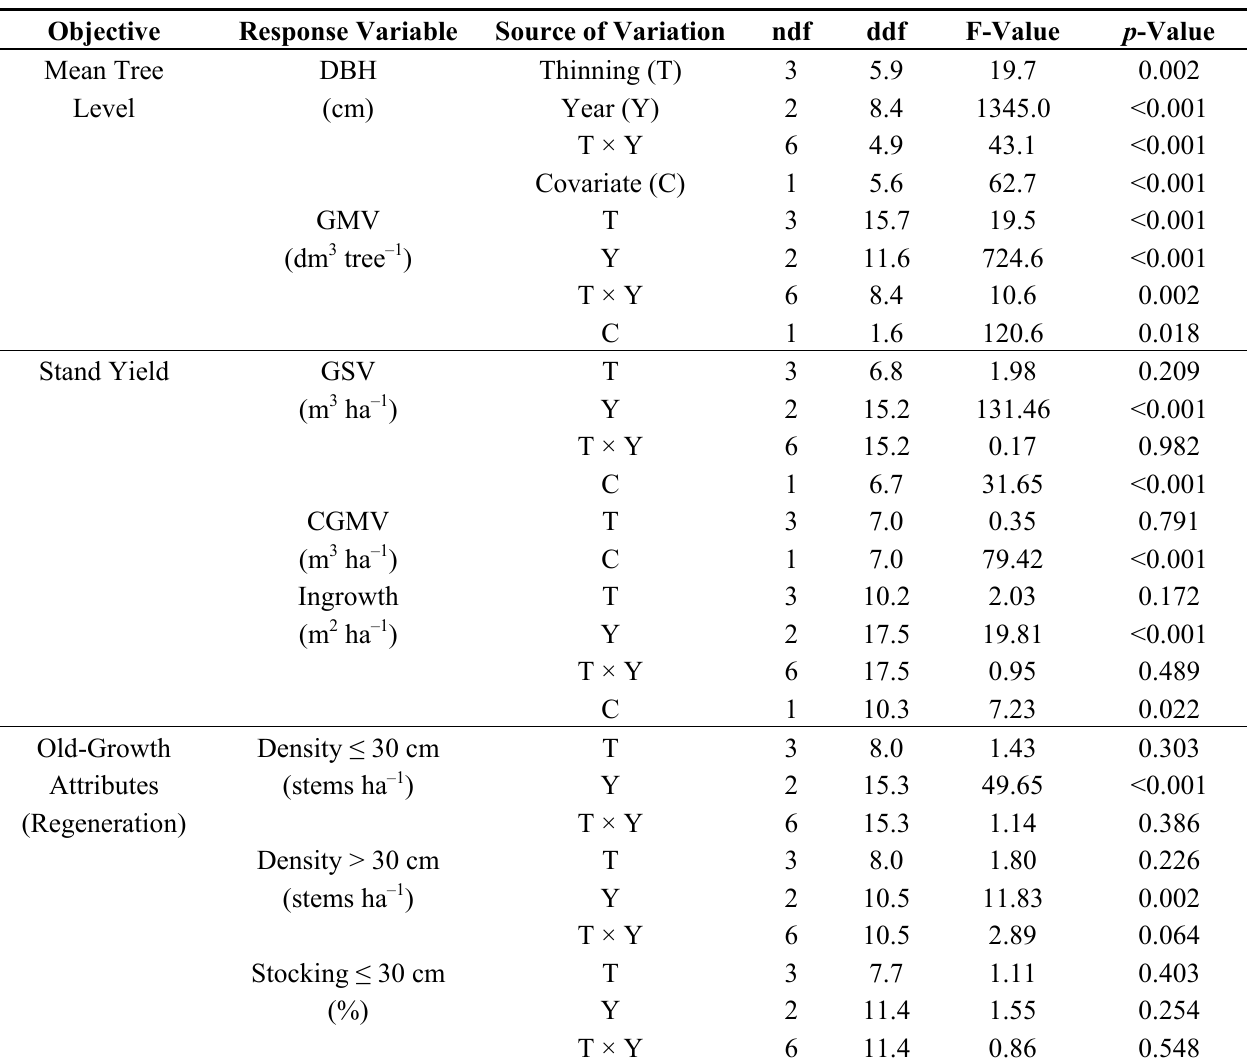
Table 2. Analyses of variance of the response variables after four commercial thinning intensities (0, 26, 32, 40% merchantable basal area removals). Abbreviations are as follows: DBH and GMV, mean diameter at breast height and gross merchantable volume of residual merchantable trees; CGMV, cumulative GMV ha –1 ; ddf, denominator degrees of freedom; GSV, gross sawlog volume; ndf, numerator degrees of freedom. Significance ( p < 0.05) indicated in